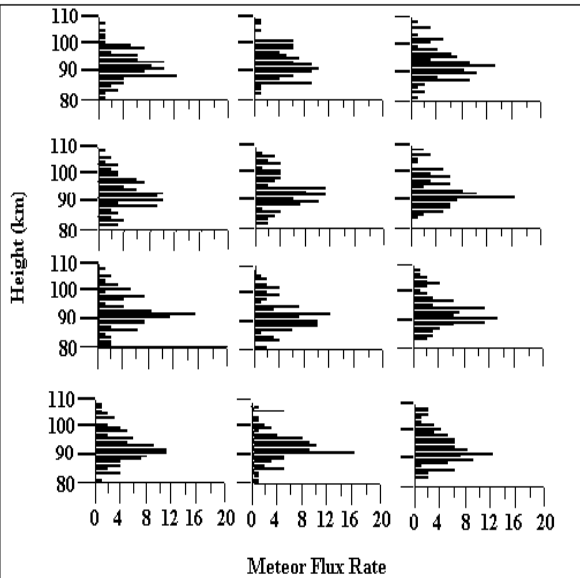
Fig. 4. Altitude distribution of meteor recorded during succes- sive 10-min intervals between 04:00–06:00LT on 17–18 November 1999.